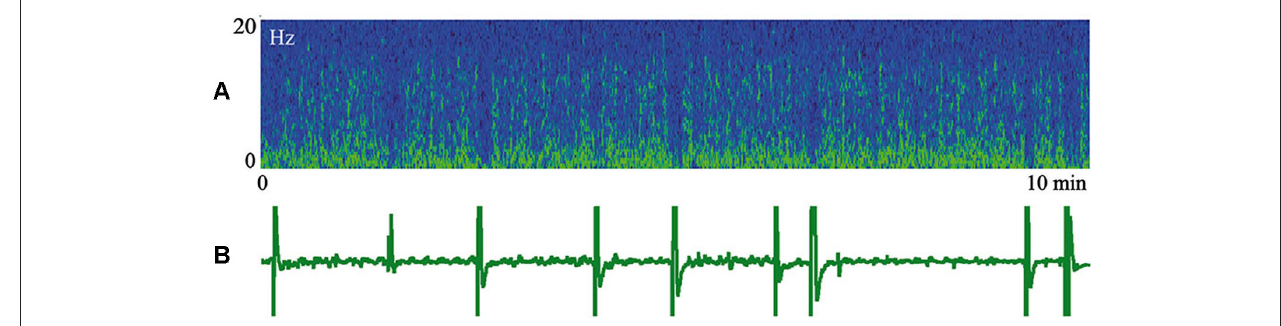
FIGURE 5 | Episode of SWS . (A) Spectrogram of the cat cortical EEG. Yellow color indicates higher power. (B) Myoelectrical activity of stomach. Technical details of the study in Pigarev et al.